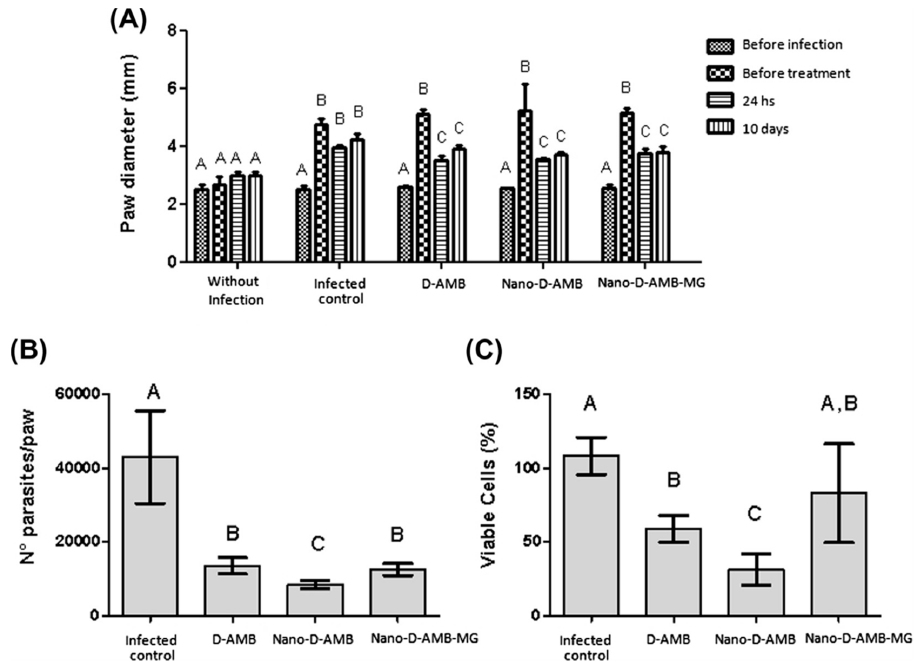
Figure 2. Distribution of the paw diameter (mm) of the mice according to duration of treatment ( A ), number of parasites per paw ( B ), and percentage of viable cells ( C ). Without infection = negative control group; Leishmania = infected animals treated with% PBS; D-AMB = infected animals treated with free D-AMB; Nano-D-AMB = infected animals treated with Nano-D-AMB; Nano-D-AMB-MG = infected animals treated with Nano-D-AMB-MG and AC magnetic field to produce magnetohyperthermia. Different letters indicate significant differences ( p < 0.05) detected by the Tukey post hoc test, where comparisons were made between the treatment groups ( A , B ) and also within the groups: before